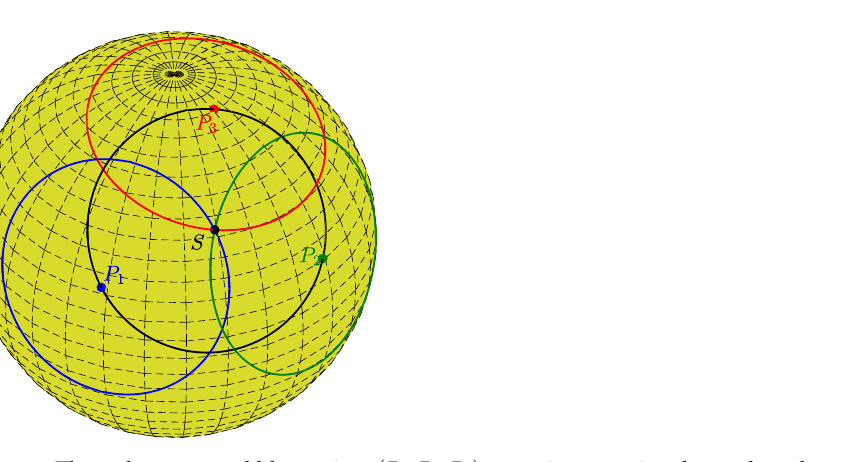
Figure 3. The red, green, and blue points ( P 1 , P 2 , P 3 ) are primary points located on the same circle (black). Each primary point defines a primary circle. All the primary circles intersect at a secondary point (black point S ). That point defines a secondary circle (black) passing through the primary